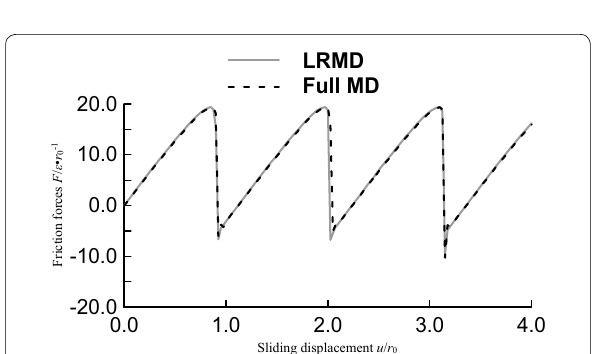
Figure 6 Friction forces comparison between LRMD simulation and full MD simulation